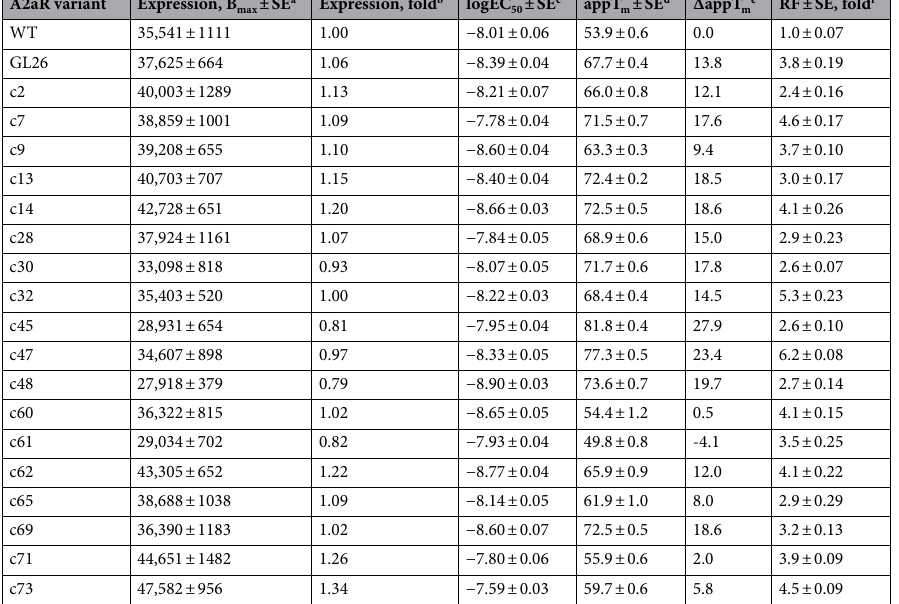
Table 1. Functional characterization of OG resistant A2aR variants retrieved by YDDS. a The level of receptor expression was estimated by ligand binding at saturating concentrations of CA200623 (B max ). The B max ± SE values were calculated from the data shown in Fig. 5A,C,E by a nonlinear regression, as described in the Methods. b The level of receptor expression relative to that of A2aR-WT, folds. c As a measure of apparent affinity we used ligand concentration at the receptors’ fractional occupancy of 0.5 (EC 50 ), estimated from the sigmoid concentration–response curves (Fig. 5A,C,E) using a three-parameter logistic regression model 32 . LogEC 50 were reported as the mean ± SE of three independent experiments performed in triplicate. d Apparent T m (appT m ) determined by the whole-yeast thermostability assay was defined as a temperature at which CA200623 binding measured at 22 ºC is reduced by 50%, and was reported as the mean ± SE of three independent experiments performed in triplicate. e Receptor thermostabilization (ΔappT m ) was defined as appT m (A2aR variant) − appT m (A2aR-WT). f RF was defined as a residual fluorescence measured in cells incubated with 20 nM CA200623 and treated with 2% OG. The values are relative to RF of A2aR-WT, and